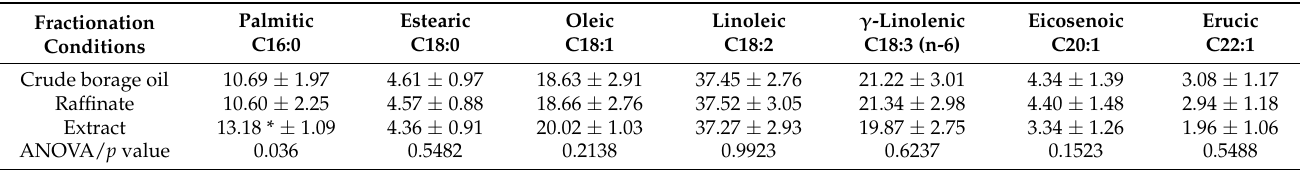
Table 6. Fatty acid compositions (%) of the different fractions obtained through countercurrent column under 200 bar at 75 ◦ C. Data are represented as the mean with 95% confidence intervals (* significat differences). Fractionation Conditions Crude borage